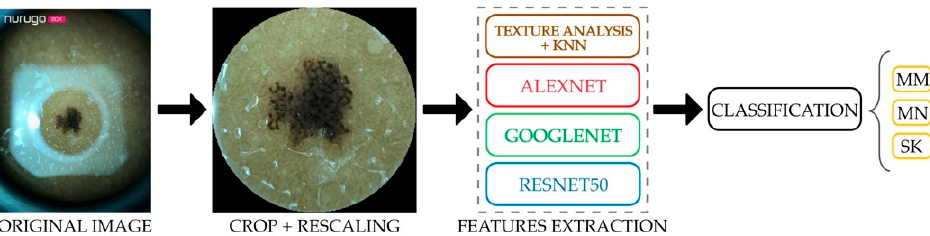
Figure 8. Block diagram of proposed approach.